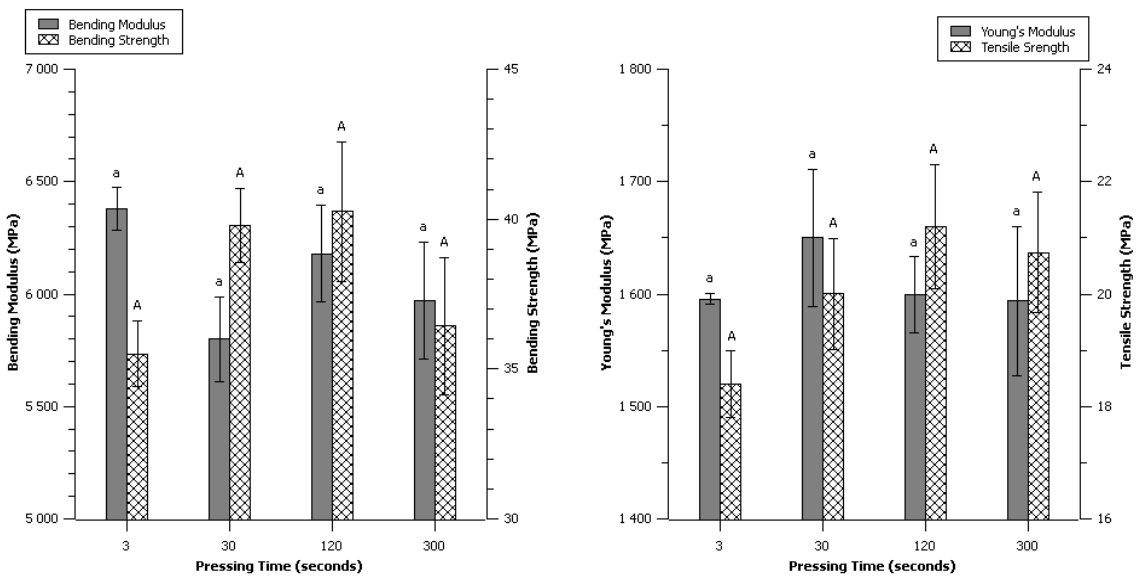
Figure 6. Effect of pressing time: Data are given as mean ± confident interval (95%). The letters on top of the column express significant difference of means according to Scheffé test with a 95% confident level. Small letters for moduli and capital letters for strengths.